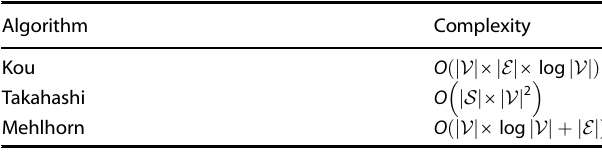
Table 5. Technical comparison of Steiner tree